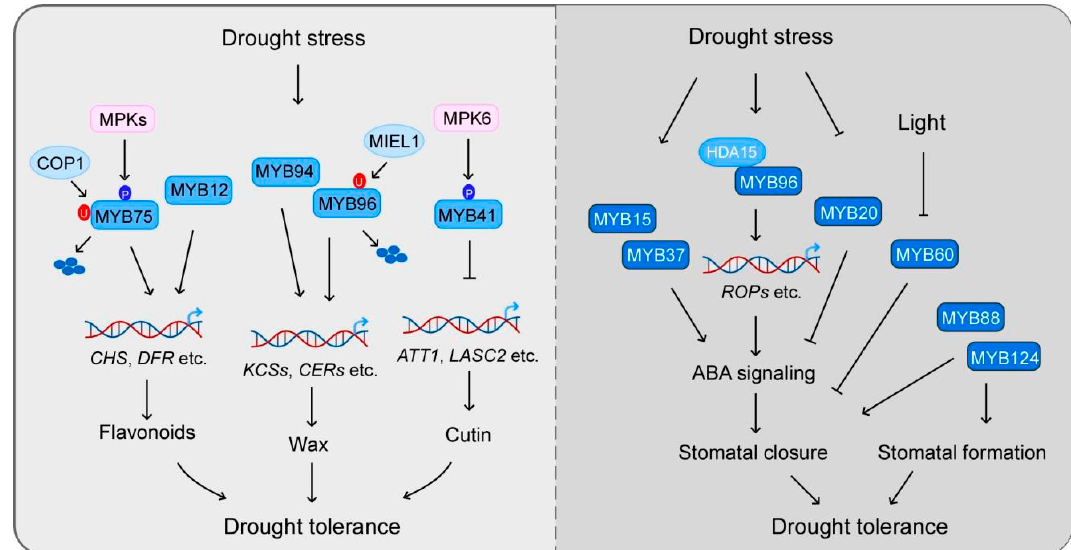
Figure 1. The pivotal role of MYB transcription factors in drought tolerance. In response to drought stress, MYB transcription factors regulate the expression of biosynthetic genes of metabolites, such as flavonoids, wax, and cutin, to modulate plant drought tolerance. Additively, MYB transcription factors participate in stomatal movement, mainly through ABA signaling. MYB60 specially regulates the stomatal aperture in response to light while MYB124/FLP and MYB88 also play critical roles in stomatal development. COP1: constitutively photomorphogenic1; MIEL1: MYB30-interacting E3 ligase 1; ROP: RHO GTPase of plants.